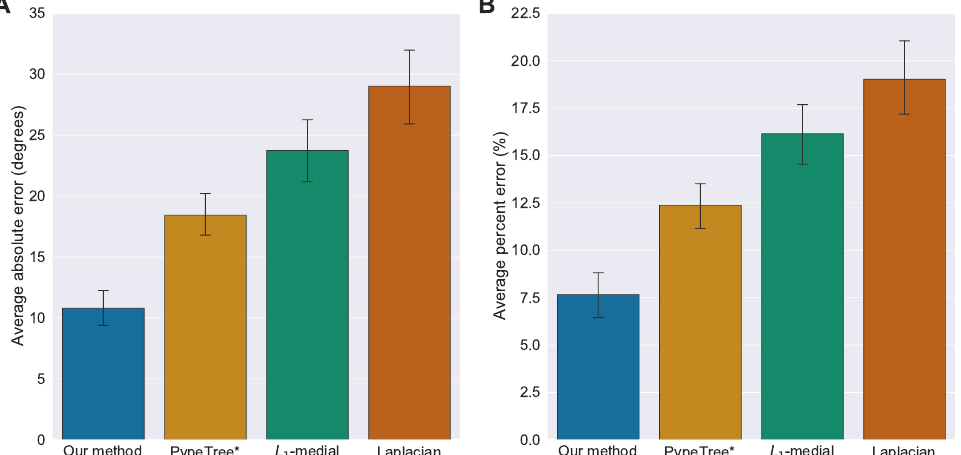
Figure 7. Accuracy of predicted angles for all methods. ( A ) Average absolute errors for each method, defined as the absolute value of the ground-truth angle minus the predicted angle. Error bars represent the standard error of the mean. ( B ) Average percent errors for each method, defined as the ratio of the absolute error to the ground-truth angle. Error bars represent the standard error of the